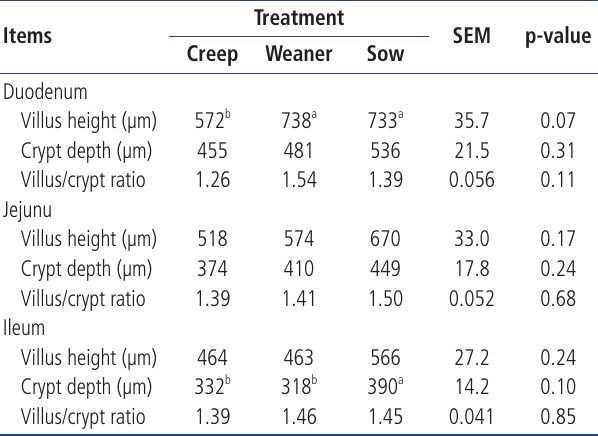
Table 5. Effect of supplementation of different creep feed types during the lactating period on the morphology of the small intestine 4 d after weaning Treatment Items